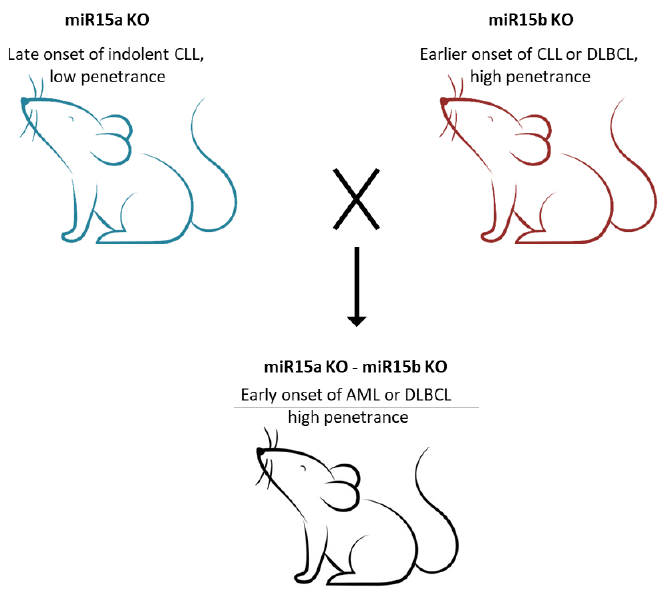
Figure 2. Double KO mice, lacking both miR15a and miR-15b, develop